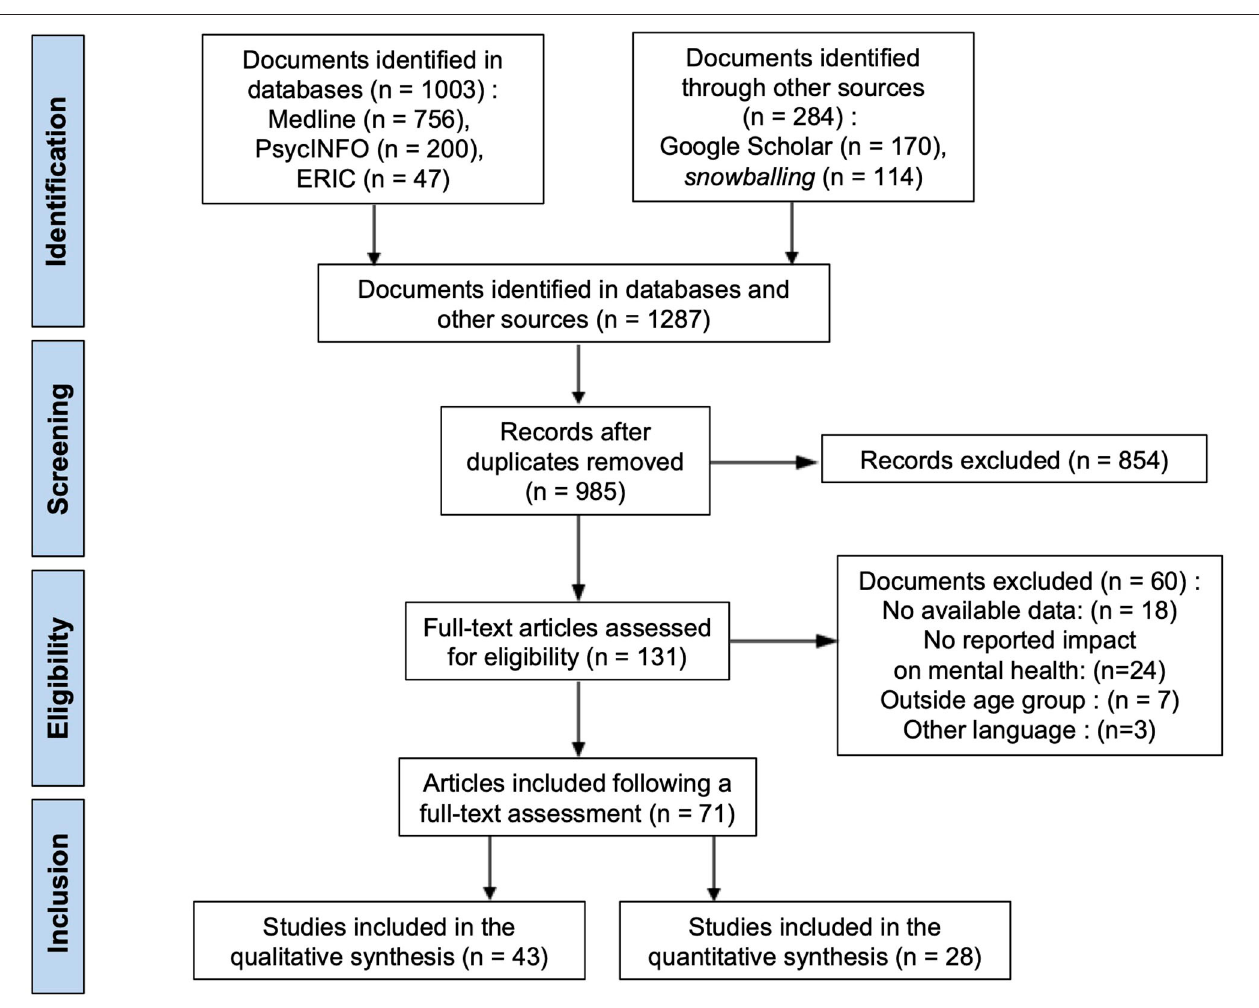
FIGURE 1 | PRISMA flow chart showing the number of included studies for the